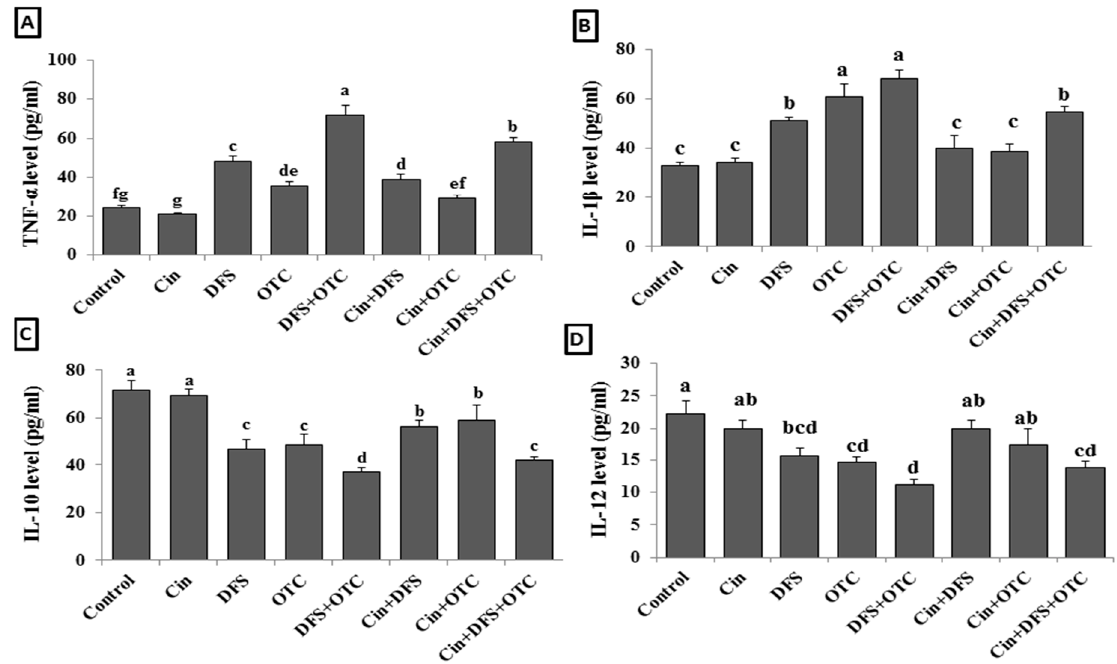
Figure 3. Serum cytokines levels; TNF- α ( A ), IL-6 ( B ), IL-10 ( C ), and IL-12 ( D ) of male albino rats treated orally with cinnamon aqueous extract (Cin, 300 mg/kg b.w./day), single dose of diclofenic sodium (DFS, 100 mg/kg b.w.) and oxytetracycline (OTC, 200 mg/kg b.w./day). Data are expressed as the mean ± SEM (n = 8). Each bar carrying different letters (a, b, c, d, e, f, g) is significantly different ( p < 0.05).